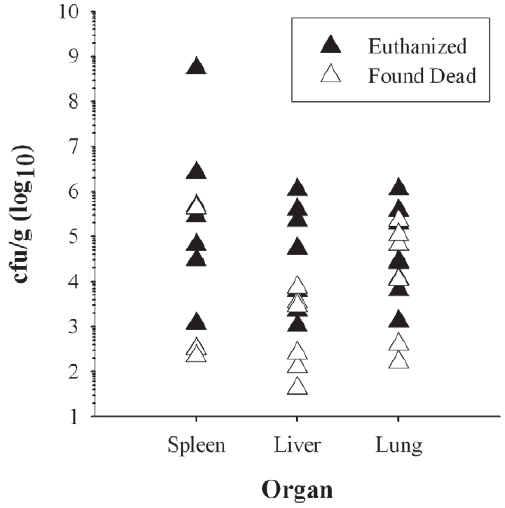
Figure 7. Bacterial load in organs of rabbits that succumbed to pneumonic tularemia. Samples of the spleen, liver, and lungs were homogenized, diluted in PBS and plated on CHA to determine bacterial load in rabbits. Graph shows log10 data for individual rabbits that were either euthanized (filled triangles) or found dead (open triangles).